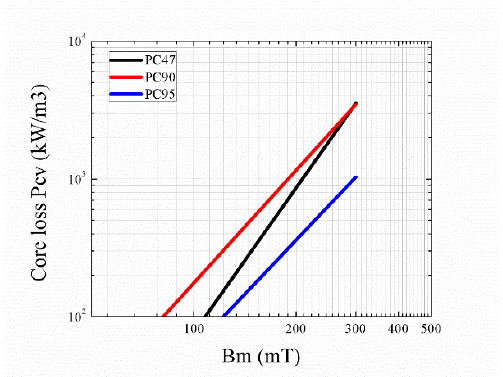
Figure 11. Curve for Pcv against magnetic flux density. Step 5: The volume parameters and ferrite core loss values are substituted into the formulae.